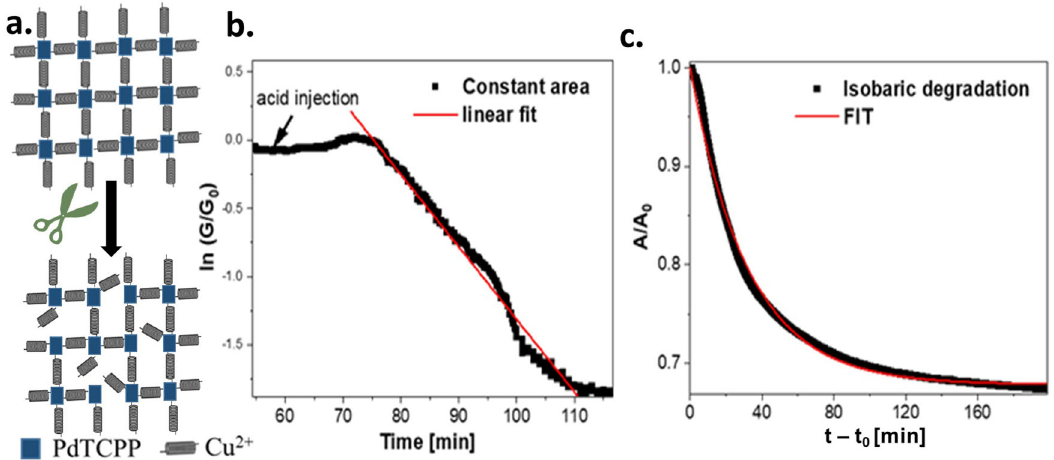
Fig. 6 Degradation of a PdTCPP-Cu monolayer. a Degradation of the representative mass spring model of the PdTCPP-Cu. b Experimental monolayer degradation curve of PdTCPP-Cu (reduction of shear modulus as a function of time) in acidic conditions. Degradation curves are shown from the injection point (black lines) and the corresponding fi t curves are shown as red lines c Isobaric degradation (reduction of fi lm area A) of PdTCPP-Cu monolayer under acidic